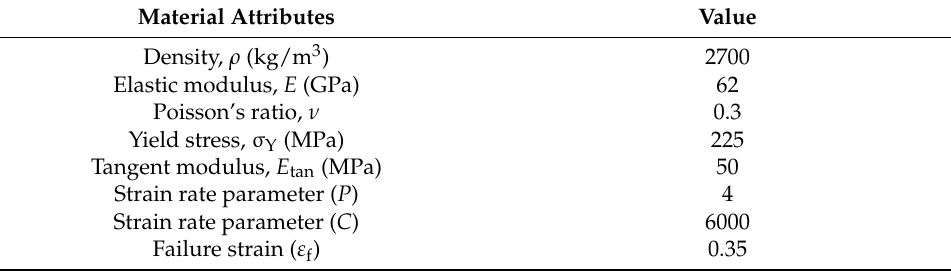
Table 4. Material attributes of honeycomb structure.